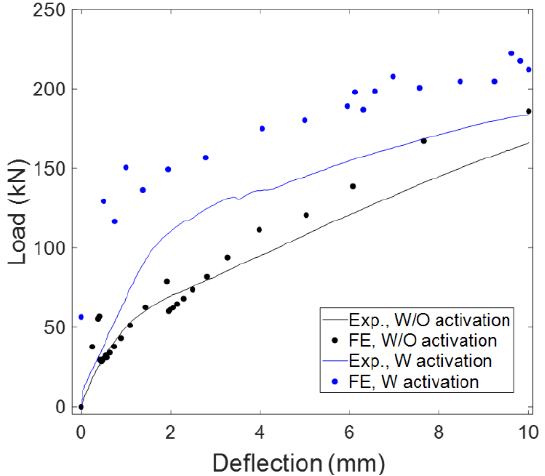
Figure 5. Comparison of experimental results and FE simulations for bending load-deflection responses of RC beams with 5 Fe-SMA bars, with (W) and without (W/O) activation of SMA bars.